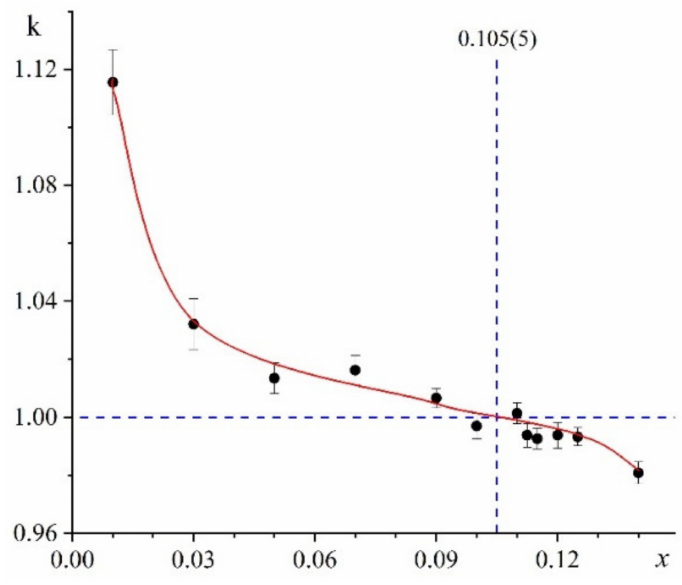
Figure 6. The effective distribution coefficient (k) of Y in the Ca 1 − x Y x F 2+ x ( x = 0.01–0.14). According to the reference data, the concentration range within which the congruently melting composition can be found is indicated within a very large interval: ∆ x